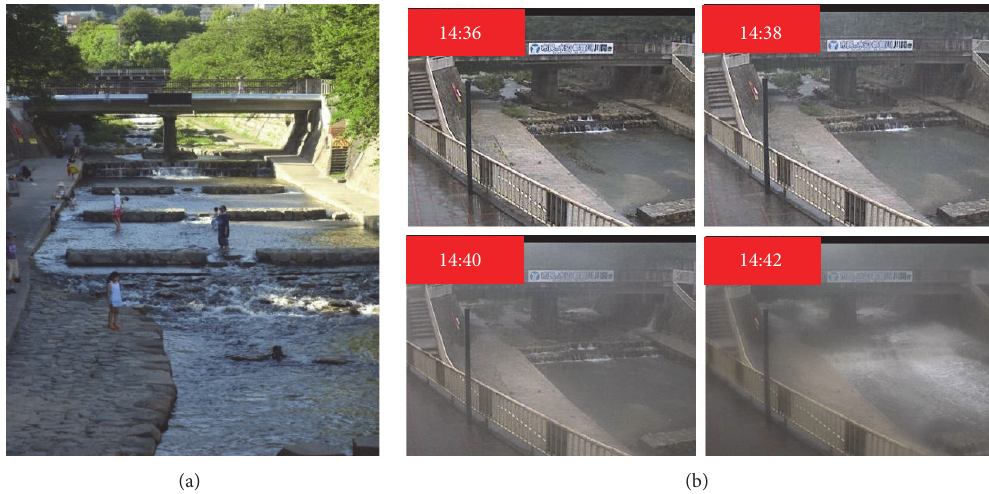
Figure 1: (a) Photograph of Toga River (July 17, 2012). (b) Field snapshots at different times in Toga River during the flood event.